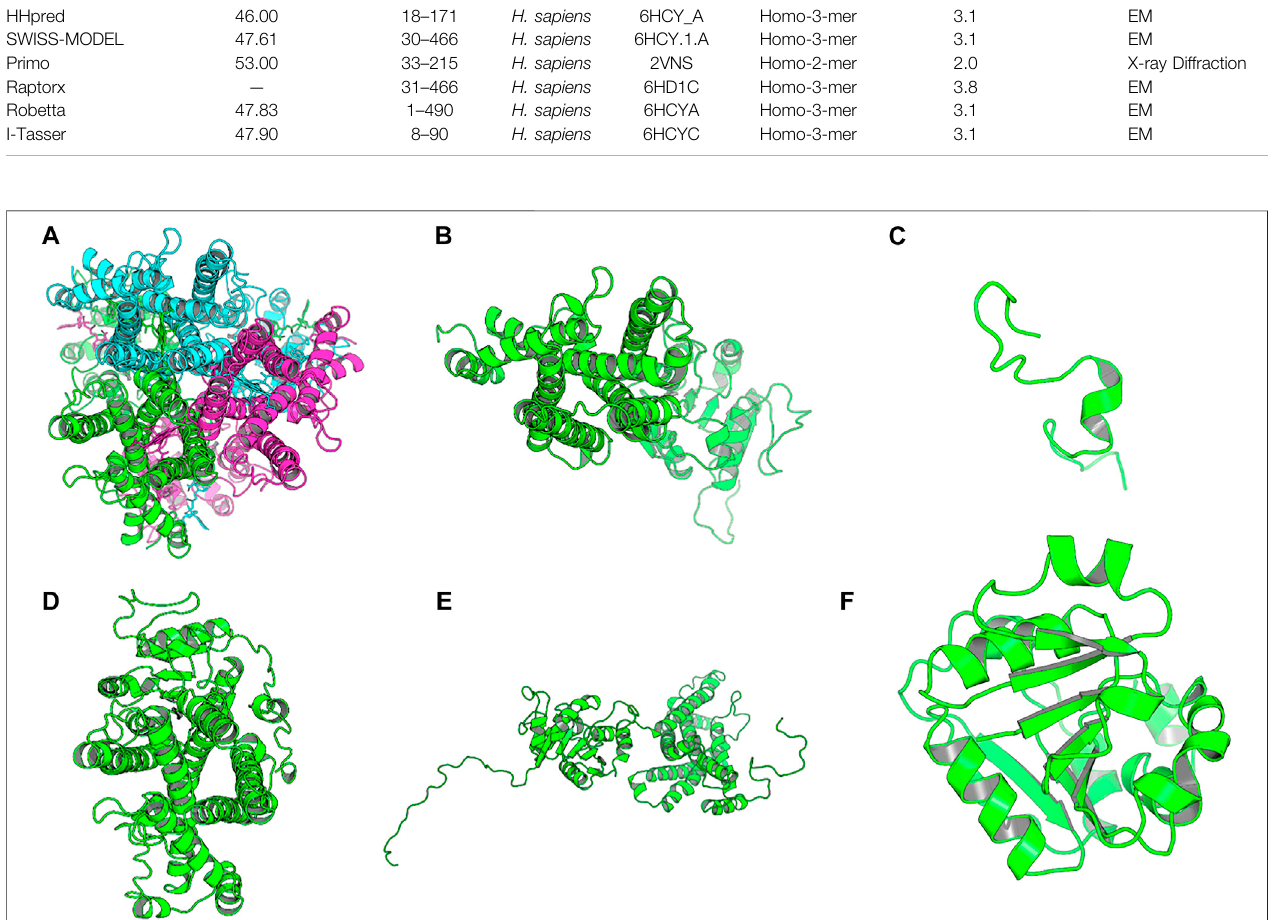
FIGURE6| Images ofthehomology models wereshown incartoonformatand coloredbychain. Image Ashows thehomology model bySWISS-MODEL, (B) top homology model by I-Tasser, (C) homology model by HHPRED, (D) homology model by RaptorX, (E) homology model by Robetta and. (F) homology model by Primo. Only the homology model by SWISS-MODEL was a homo trimer, the rest were single chain models and the used template; human STEAP4 is a homotrimer.